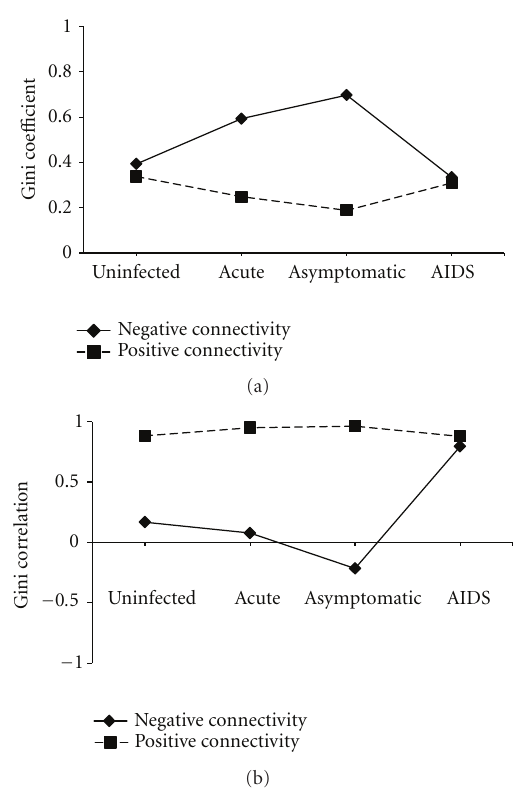
Figure 2: The Gini coe ffi cients and Gini correlations of positive and negative connectivity in GCNs of the uninfected subjects and HIV-1 patients at three di ff erent stages (acute, asymptomatic, and AIDS).